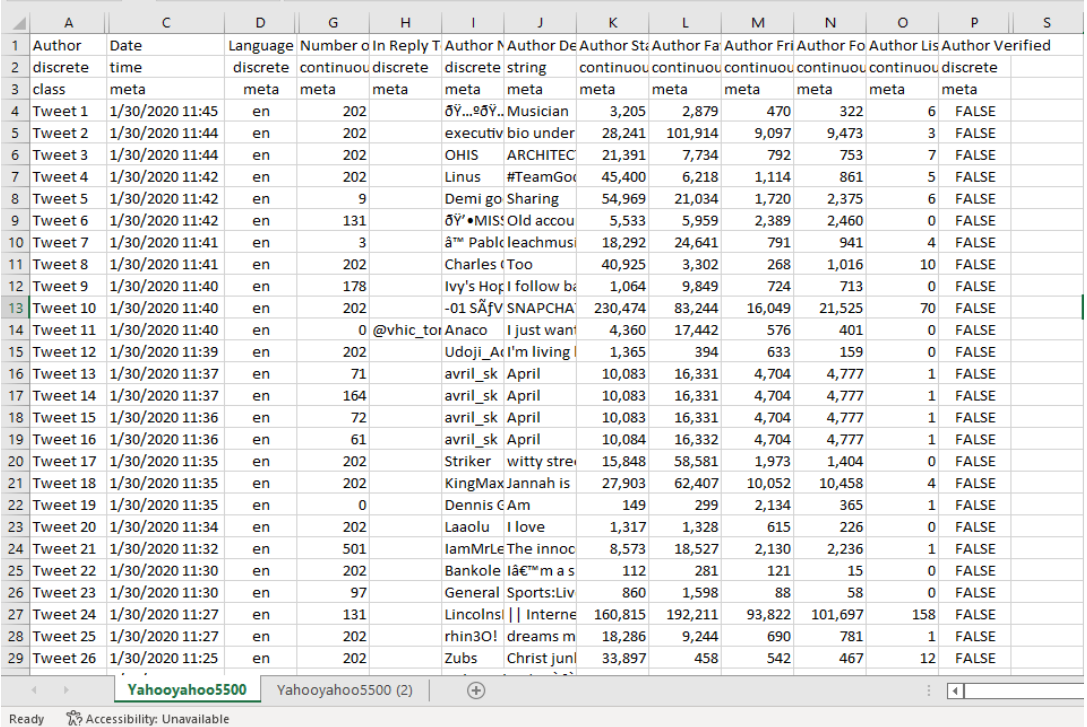
Figure 2. Proposed Content Analysis Framework.